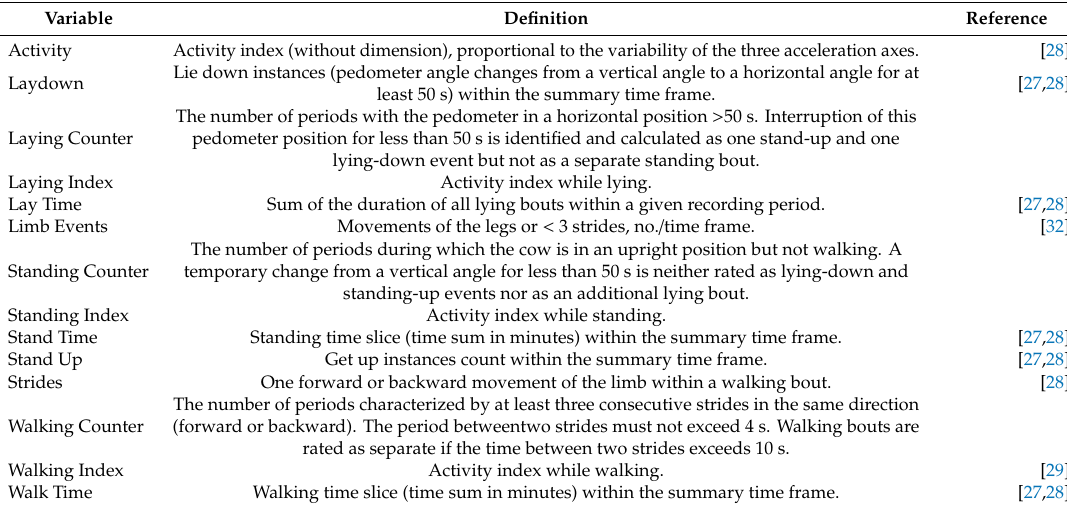
Table 2. Variables analyzed and